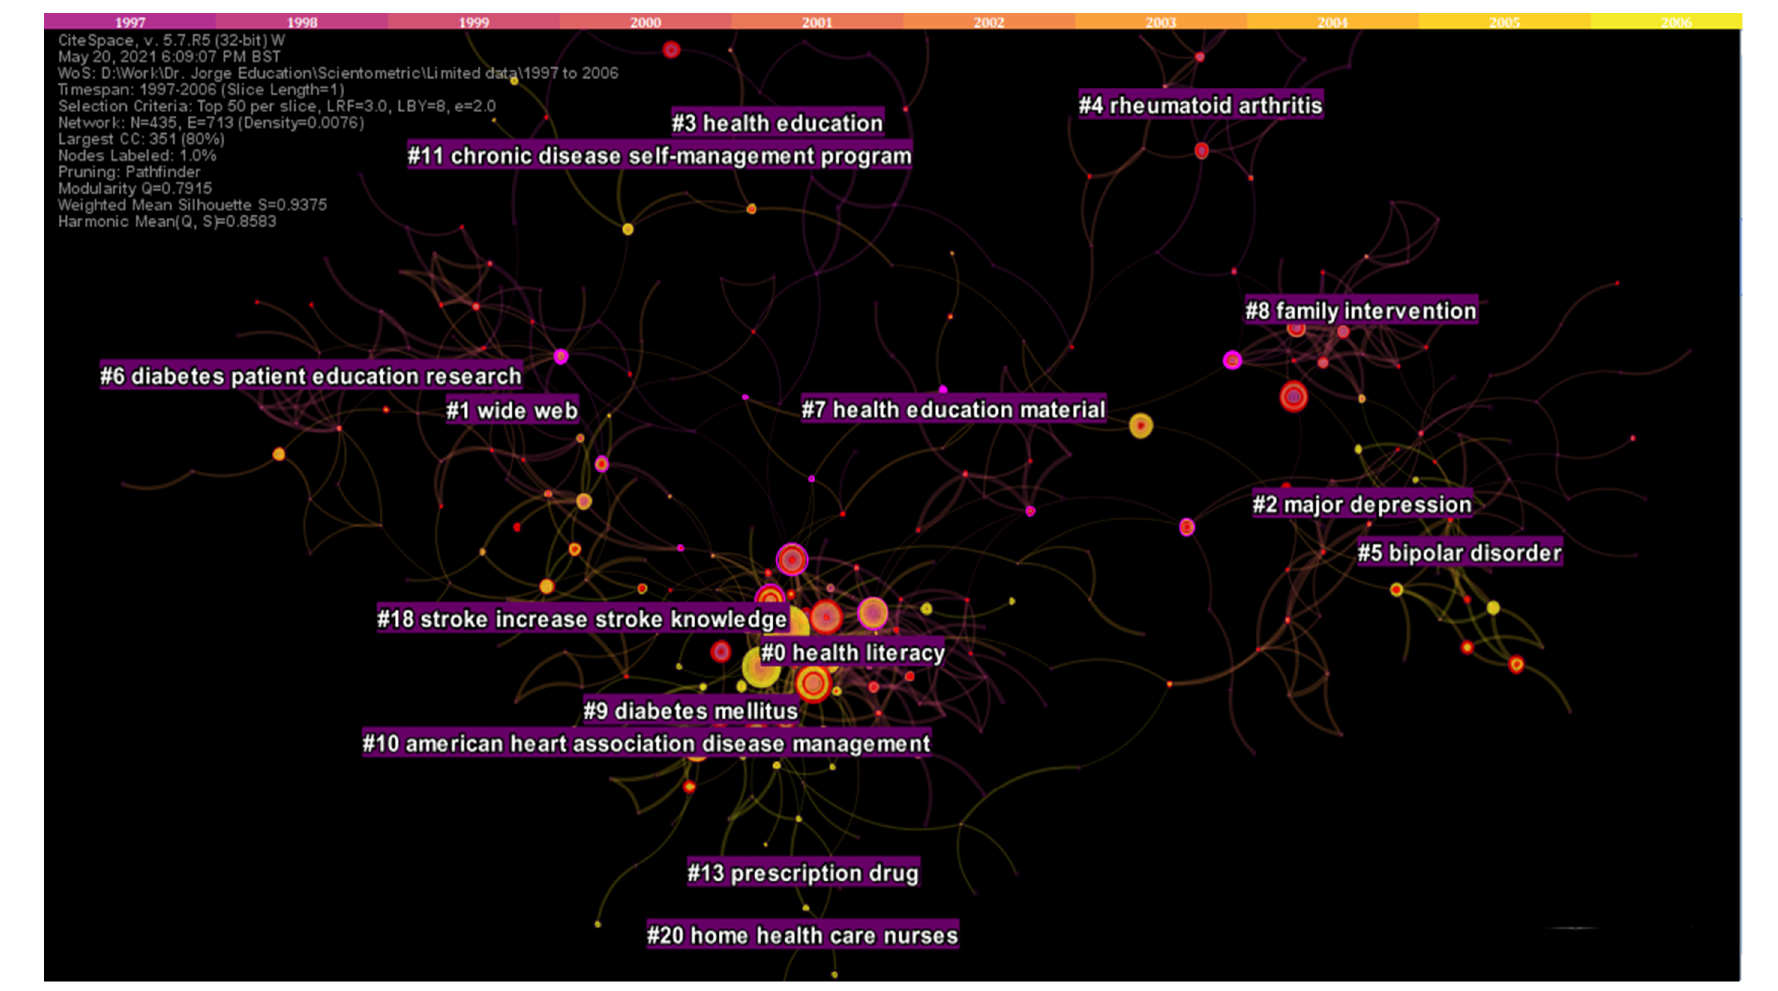
Figure 5. Top clusters of research from 1997 to 2006.